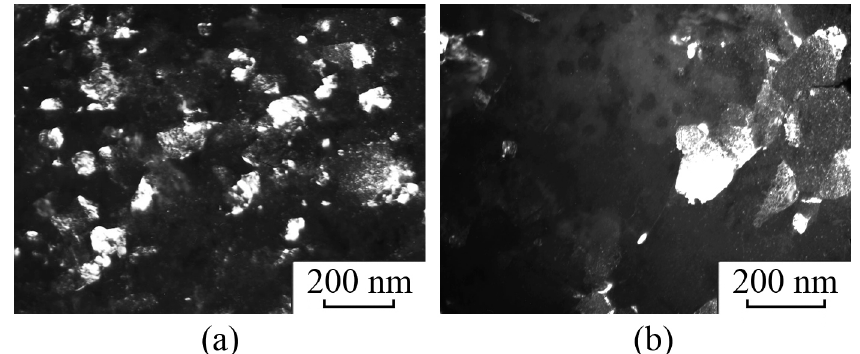
Figure 15. The effect of deformation temperature on the nickel concentration )Ni( c . ( a ) in austenite of the alloy Fe 55 Ni 36 Al 9 aged at 873 K for 3 h; ( b ) in the binary alloy Fe 64.9 Ni 35.1 ; ( c ) in austenite of the alloy Fe 55 Ni 36 Al 9 preliminarily aged at 873 K for 3 h after its HPT treatment with ε = 4.8 (1 rev.) and subsequent isothermal annealing at 573 K for 50 min. The round symbol corresponds to the value characteristic of the state obtained after quenching from 1373 K in water.